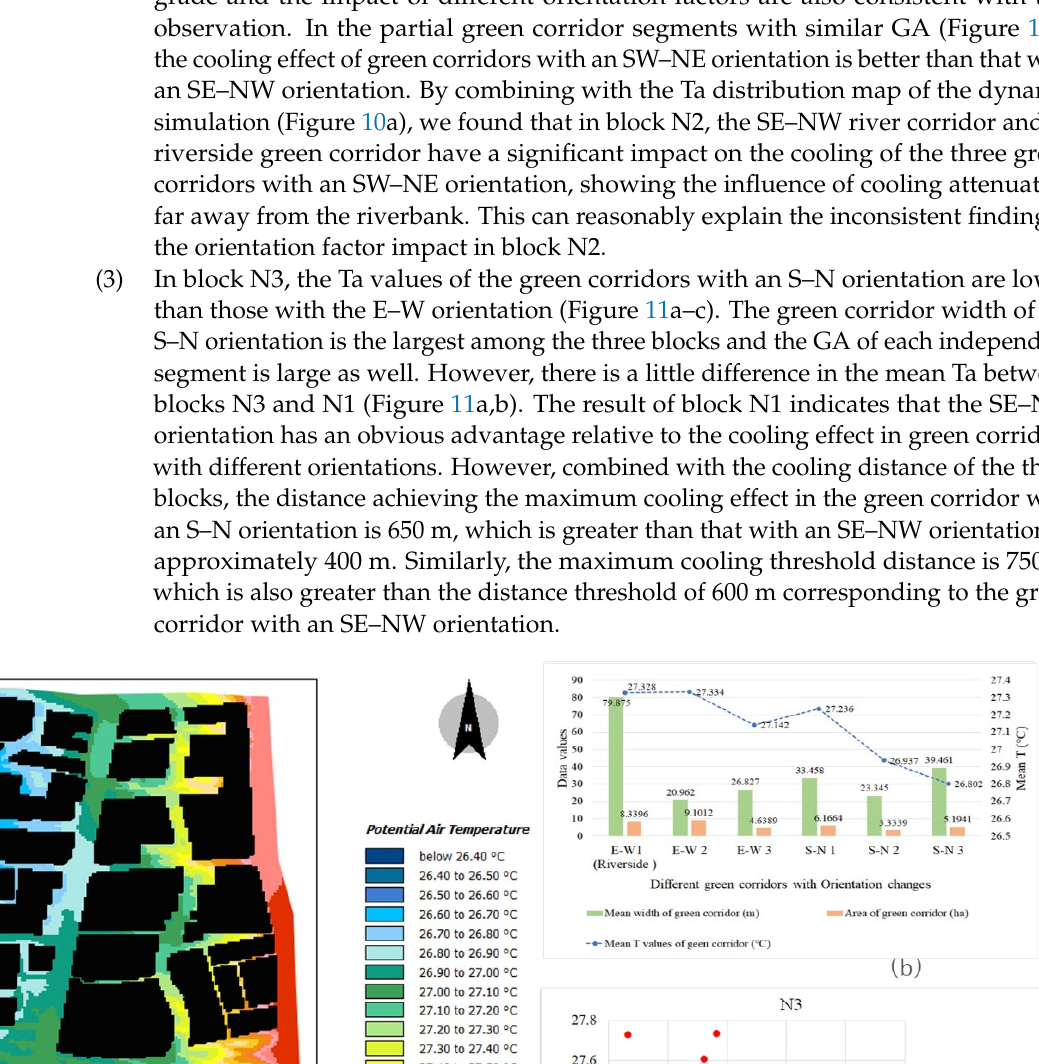
Figure 11. Ta distribution status of green corridors with different orientations at 14:00 and 1.5 m height in block N3 and comparison of the Ta difference of each green corridor segment. ( a ) Spatial distribution of Ta using ENVI-met simulation. ( b ) Comparison of mean temperature of six green corridors inside the block. The green corridor number is shown in Figure 2c. It can be observed that the Ta values of the S–N oriented green corridors with a small angle and with the summer monsoon wind direction are mostly lower than the internal Ta values of the E–W oriented green corridors. ( c ) Comparison of Ta scatter distributions of two groups of green corridors with different orientations, the same grade of D factor and similar connection degree. It can be seen that most of the internal Ta of green corridors with an S–N orientation (marked by green points) are located below the internal Ta of green corridors with an E–W orientation (marked by red